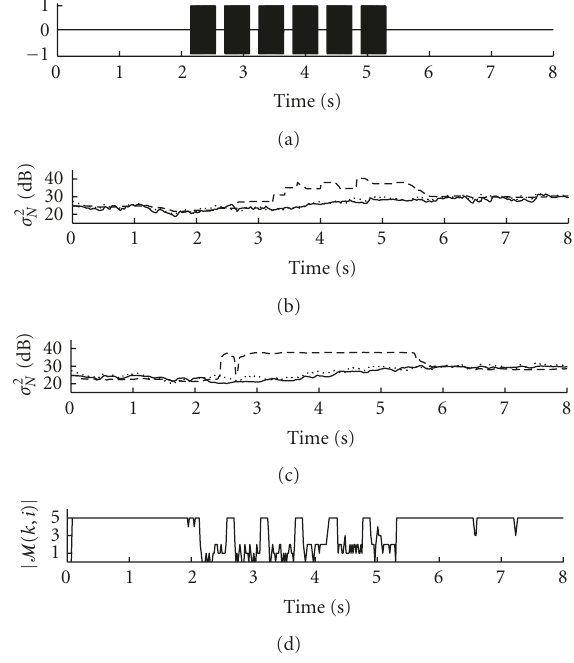
Figure 2: Synthetic noise tracking example. (a) Clean synthetic signal. (b) Comparison between true noise PSD (dotted line), proposed approach (solid line), and MS (dashed line) for DFT bin centered around 937.5 Hz. (c) Comparison between true noise PSD (dotted line), DFT-subspace approach (solid line), and QB approach (dashed line) for DFT bin centered around 937.5 Hz. (d) Cardinality of the set M ( k , i ) for the frequency bin centered around 937.5 Hz.